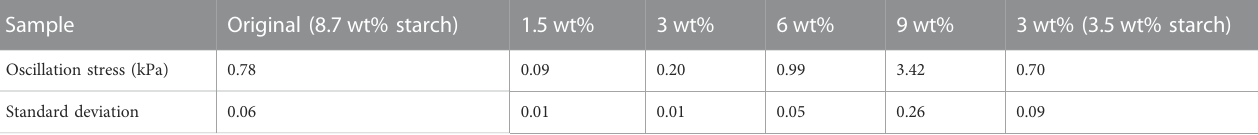
TABLE 3 Yield stress as measured by the oscillation stress (kPa) at cross-over point of storage and loss modulus in the amplitude